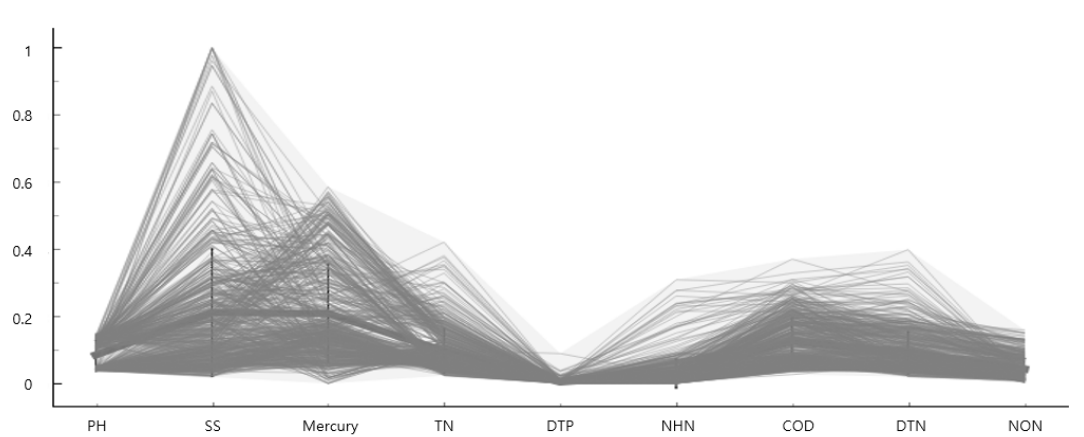
Figure 7. Train score (AdaBoost). Figure 8 corresponds to a line plot of the training output and shows the distribution of values for each variable.